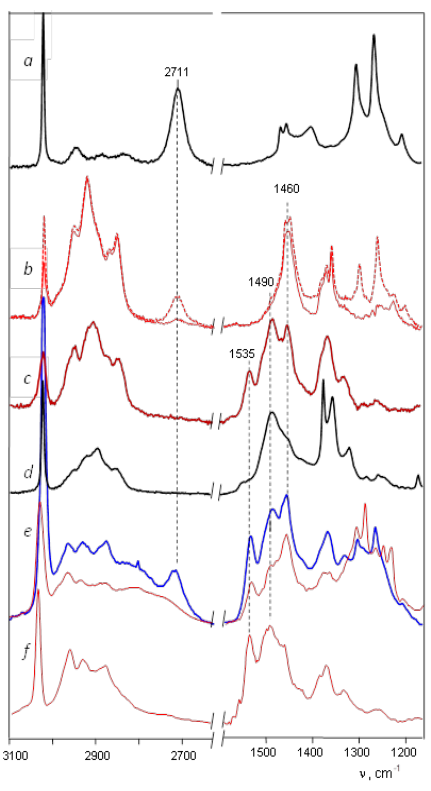
Figure 2. IR spectra of ( a ) Initial salt CH 3 - cyclo -C 5 H 9 {Cl 11 − }, from which all solutions were prepared; ( b , с ) solution in CH 2 Cl 2 without (dashed line) and with the subtraction of the spectrum of the initial salt (bold line) freshly prepared ( b ) or aged for several hours ( c ); ( d ) C 4 H 7+ {Cl 11 − } crystals that grew after 1 – 2 days; ( e ) a solution in d 4 -DCE (red) and solid residue from the evaporated solution (blue); ( f ) a solution in d 2 -1,1,2,2-tetrachloroethene. Spectra of all solutions (red) are given with the solvent spectrum subtracted.